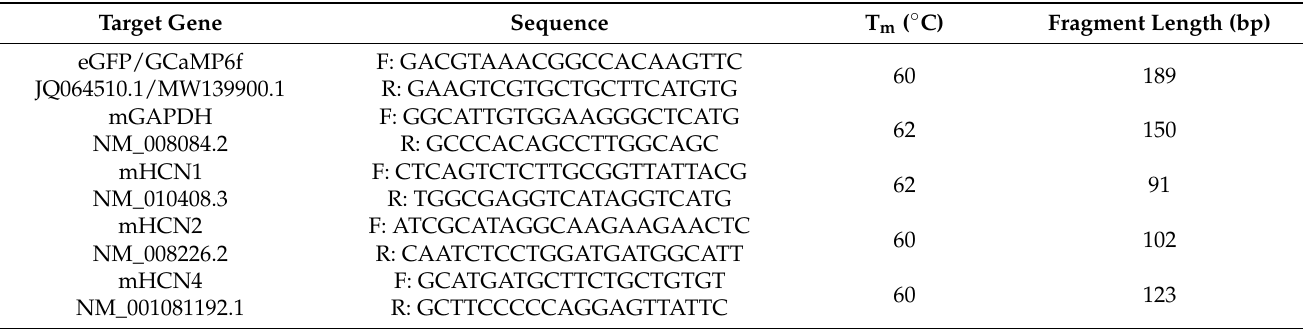
Table 5. Sequences of qPCR primer pairs. Primer sequences, accession numbers, melting temperatures, and amplicon sizes for target and reference genes used in qPCR